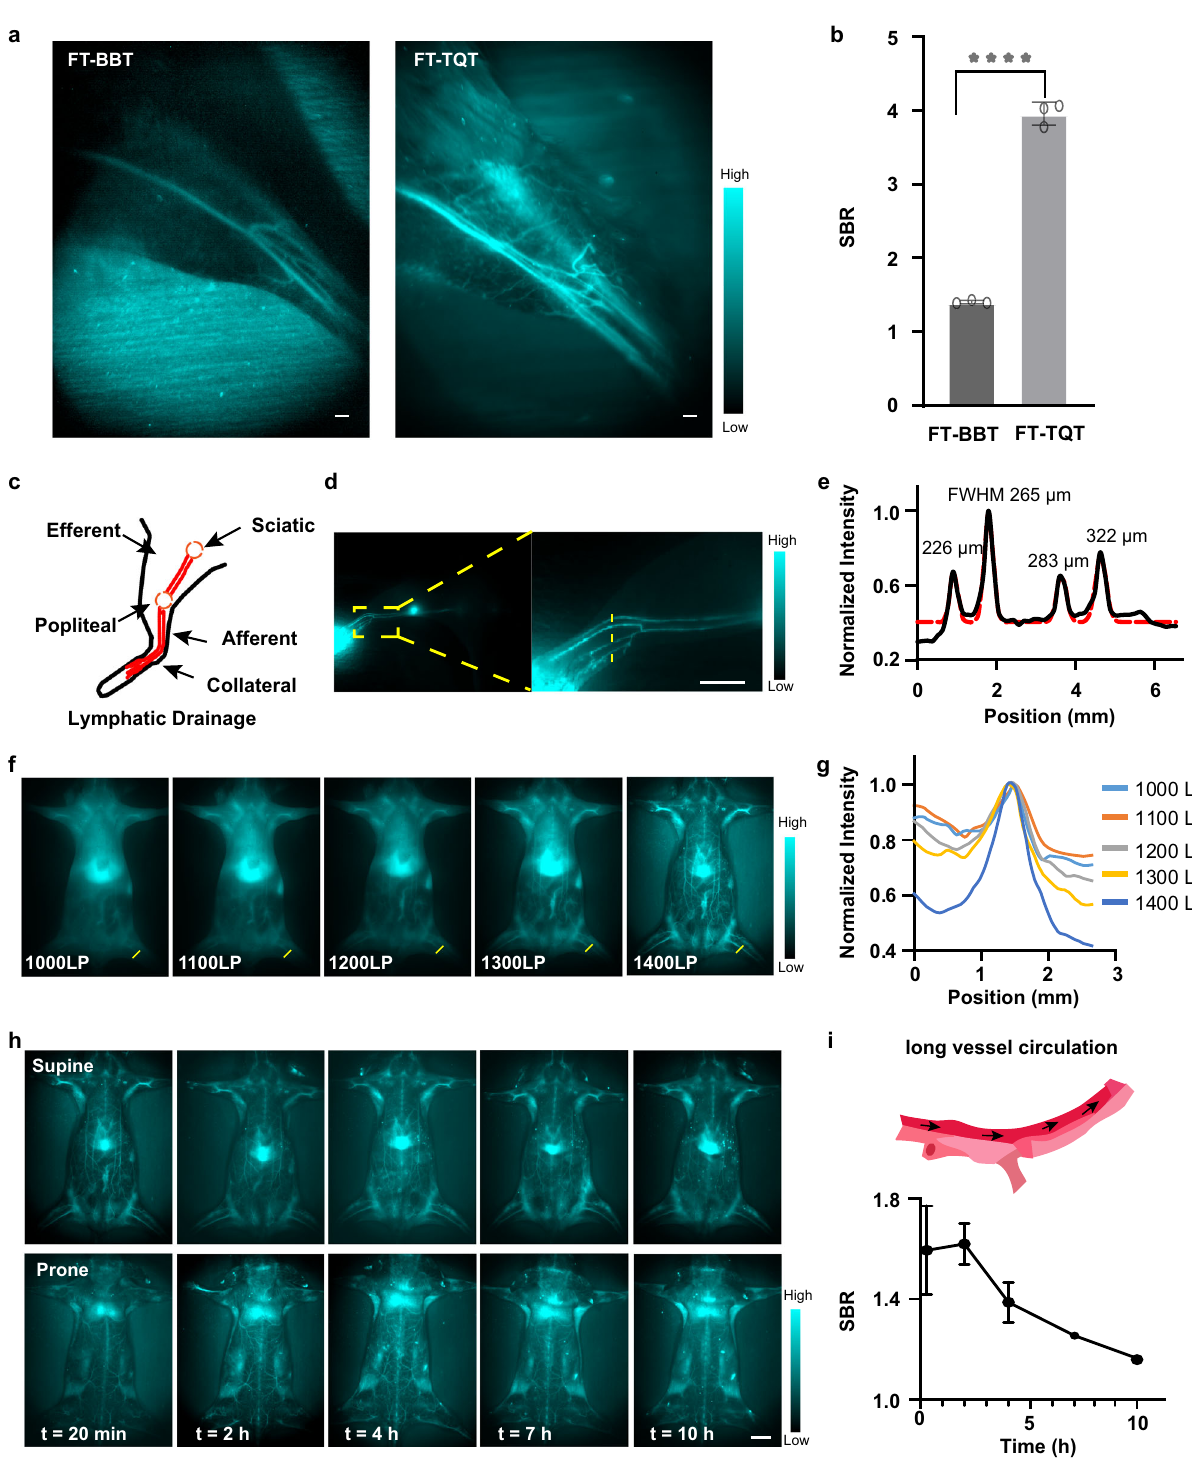
Fig. 4 In vivo NIR-II imaging for evaluation of the circulatory system and lymphatic drainage. a NIR-II bioimaging of mice hindlimb at 1400 nm LP fi lter by FTs administration. Scale bar, 1 mm. b SBR (vessel-to-muscle signal ratio) in balb/c mice hindlimb images by FTs administration. **** P < 0.0001. P value was obtained from unpaired two-tailed t tests. The bars represent mean ± s.d. derived from n = 3 independent mice. c Schematic illustration of the anatomical structure of the lymphatic system in the hindlimb of Balb/c mice. d Fluorescence images of lymphatic drainage using FT-TQT as contrast agents in the hindlimb of Balb/c mice on an InGaAs camera. Scale bar, 5 mm. e Cross-sectional fl uorescence intensity pro fi les (black solid) and Gaussian fi t (red dotted) along the yellow line in d . f The high brightness of the FT-TQT affords whole-body imaging with sequential LP fi lters from 1000 to 1400 nm. The longer NIR-II window increases the imaging quality with reduced scattering and auto fl uorescence. g Cross-sectional pro fi les of the vessel to normal tissue ratio across the dashed yellow lines (70 mW cm − 2 ). h In vivo circulation of FT-TQT. (imaging condition: 200 s exposure time, 1400 nm window) Scale bar, 5 mm. i Scheme of long vessel circulation of the FT-TQT and measured the vessel to normal tissue ratio over post-injection time points. Data are presented as mean ± s.d. derived from n = 3 independent mice. The detailed imaging parameters for each image are listed in Supplementary Table